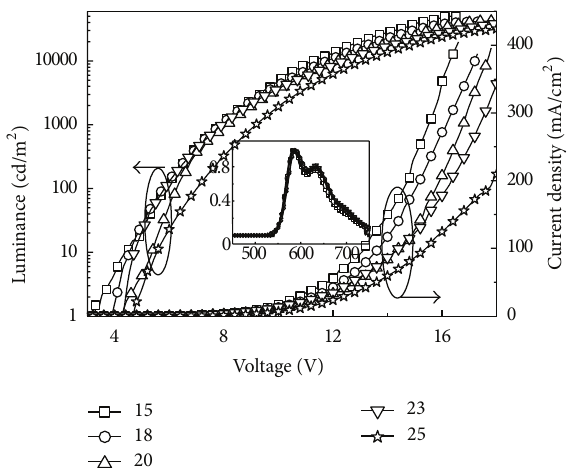
Figure 2: Luminance-bias voltage-current density characteristics of devices A1, A2, A3, A4, and A5. Inset: EL spectra of devices A1- 5 at voltage of 8V. Note that the numbers in the legend represent concentration of (tbpbt) 2 Ir(acac) dopant in the devices.